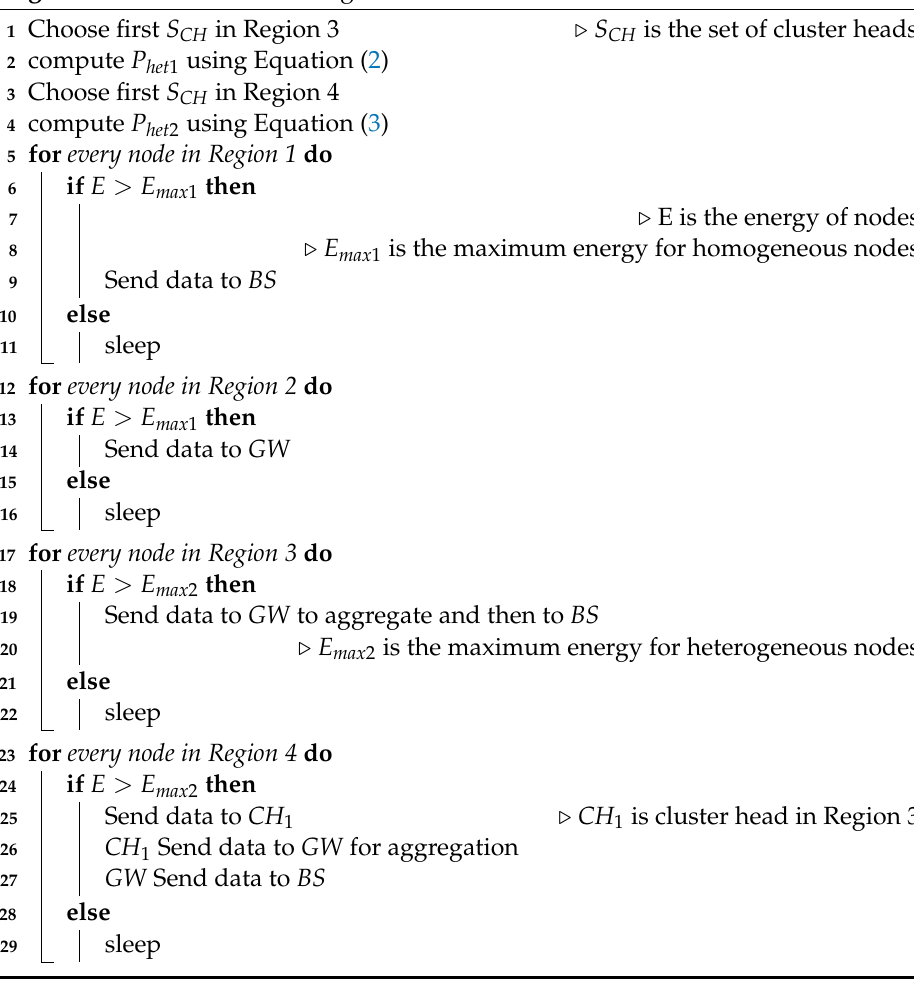
Algorithm 2: Selection of in Regions 3 and 4 and data